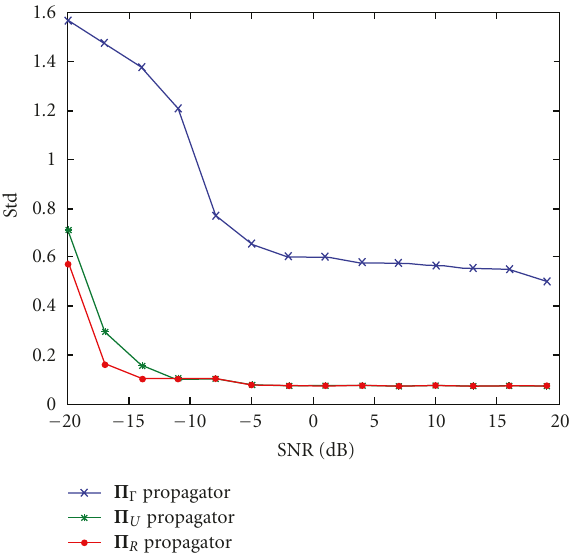
Figure 4: std of estimation errors as a function of SNR for propagator and modified propagator.